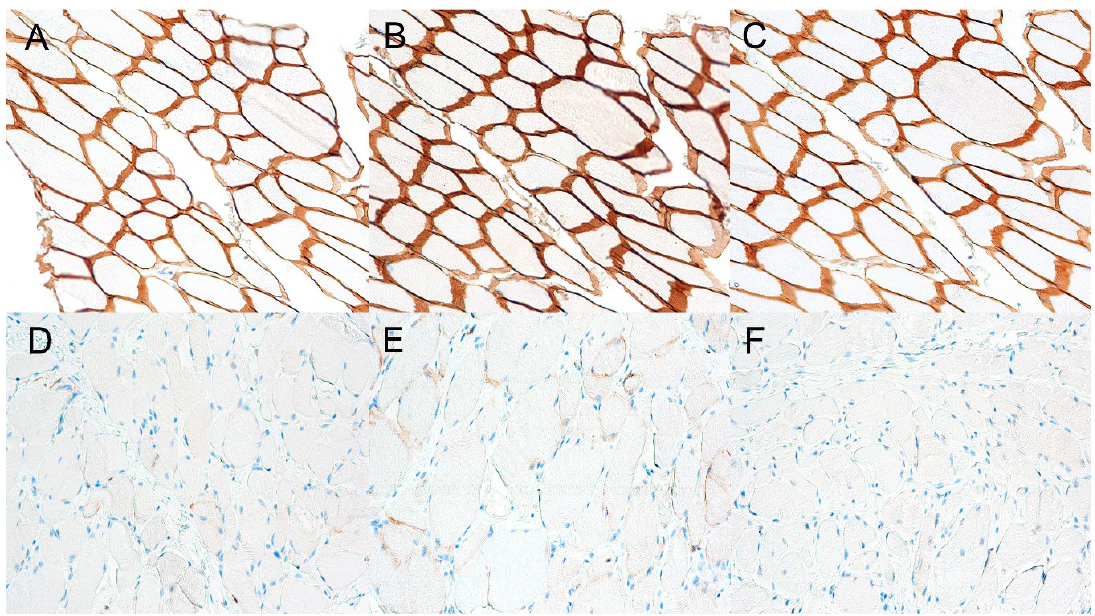
Figure 3. Control dog. Immunostains for the C-terminus ( A ), rod domain ( B ), and N-terminus ( C ) of the dystrophin in the diaphragm of a normal dog showing diffuse and strong sarcolemmal staining (positive control, transverse sections, objective 20x). In the affected dog, there was a total loss of positivity using both the anti-C-terminal ( D ) and N-terminal antibodies ( F ), and a very mild and multifocal signal with the anti-Rod antibody ( E ) (transverse sections, objective 20x).